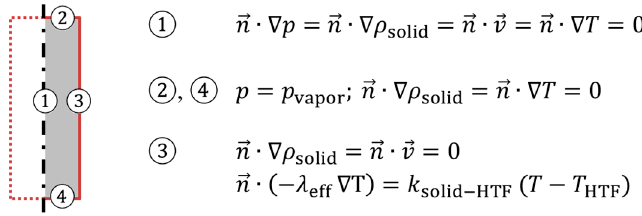
Figure 3. Boundary conditions for heat and mass transfer in the 2D model domain (see Figure 2) with v being the Darcy flux and n the normal vector.